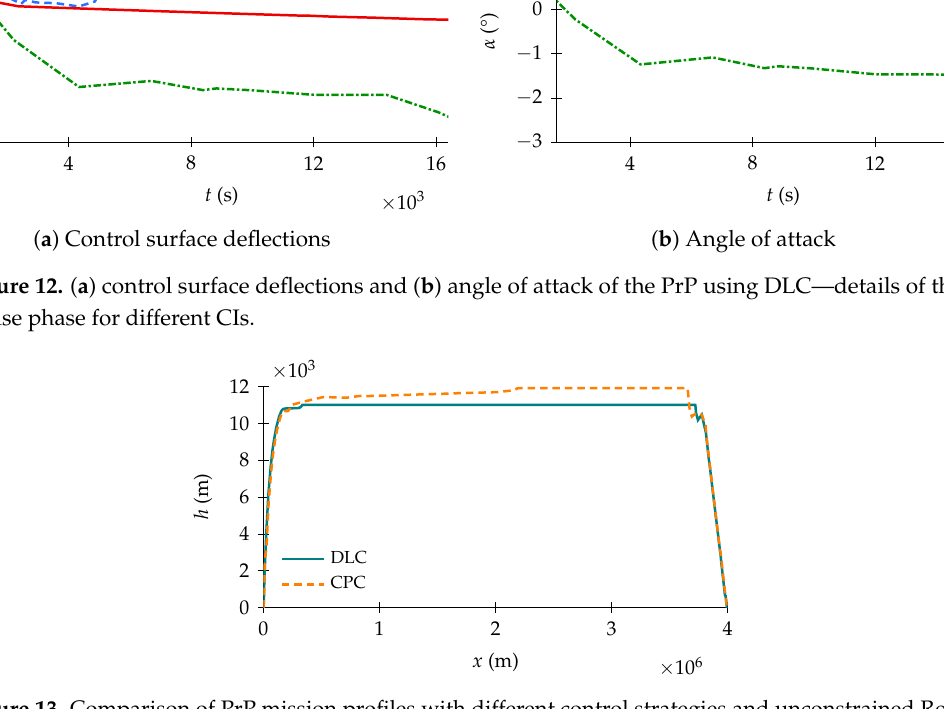
Figure 13. Comparison of PrP mission profiles with different control strategies and unconstrained RoC during the cruise phase, for a unit